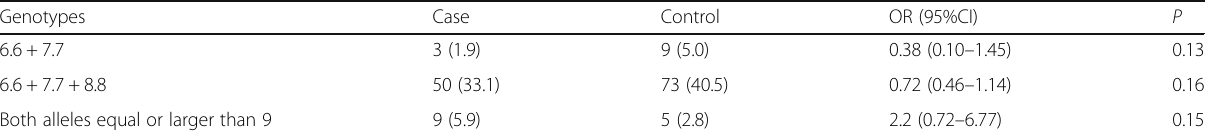
Table 4 Association between homozygous genotypes and risk of CRC